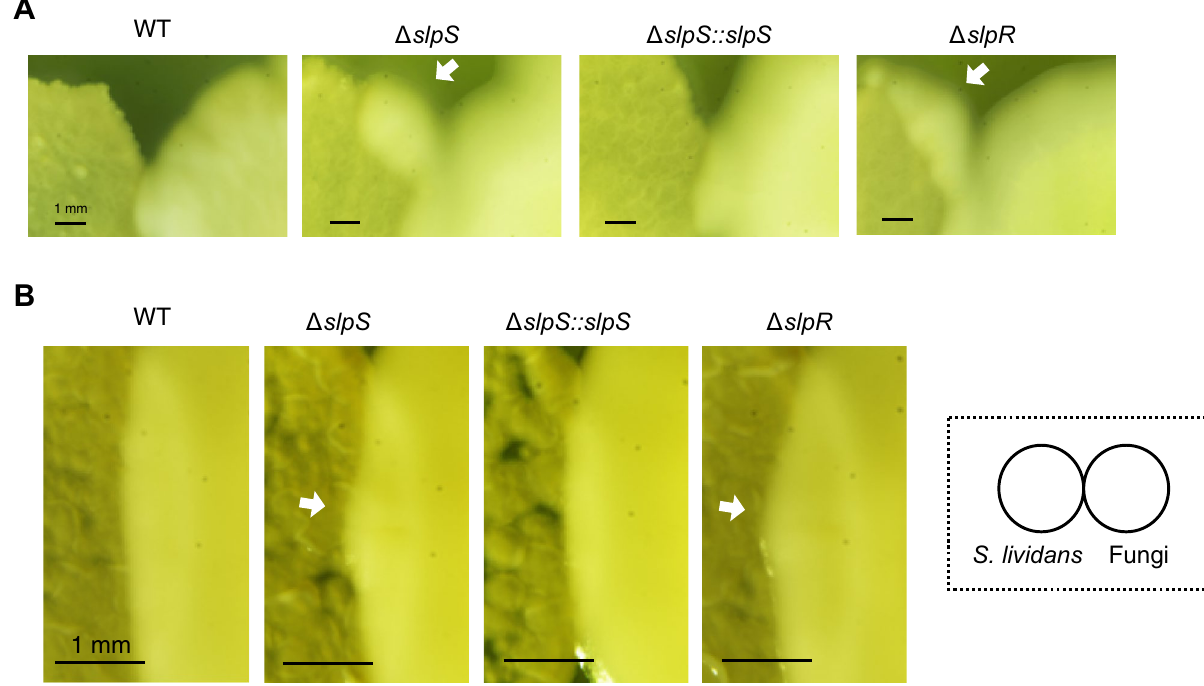
Figure 3. Deletion of SLP genes affects the microbial competition between S. lividans and fungi. Microscopic analyses of the microbial competition between S. lividans and fungi. ( A ) S. cerevisiae and ( B ) S. pombe were co-cultured with S. lividans on solid YES medium for 7 days. S. lividans and fungi were inoculated on the left and the right sides, respectively. White arrows indicate fungal invasion. The slpS -complemented strain was constructed by replacing the deleted slpS gene with intact slpS gene in its native chromosomal locus. In case of co-culture with S. cerevisiae , S. lividans and the fungus were cultured on a cellophane placed on the solid medium. Scale bars, 1